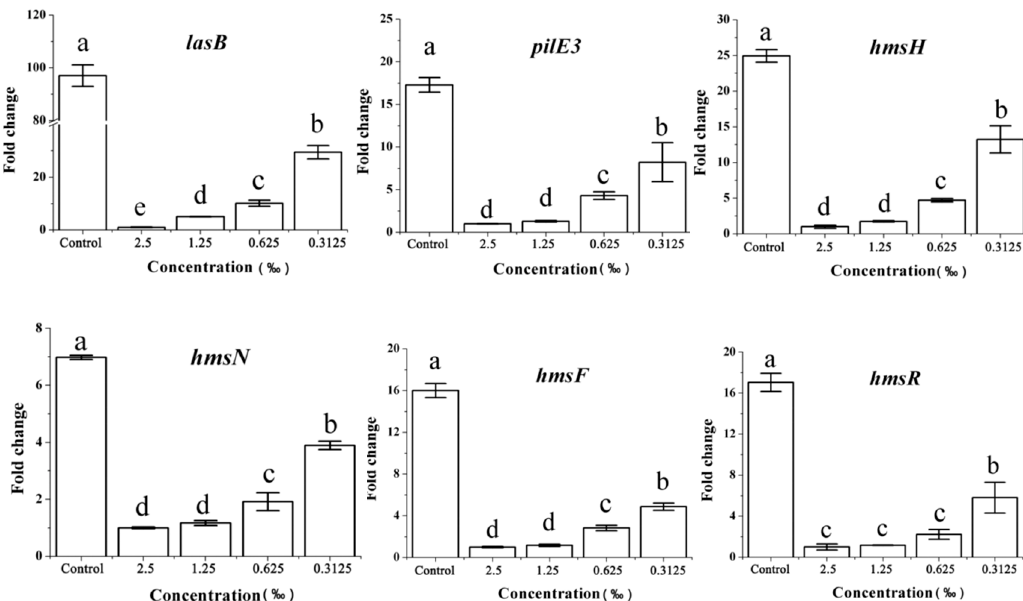
Figure 8. E ff ect of C. camphora EO on the expression of genes regulated by LuxI-LuxR system. Quantitative RT-qPCR of the vioA, vioB, vioC, vioD, vioE, lasA, lasB , and pilE3 genes. Expression of the housekeeping gene, rpoD , was used as the internal control for each sample. Bars indicate standard errors and di ff erent letters ( a – e ) above the bars represent significant di ff erences ( p < 0.05).